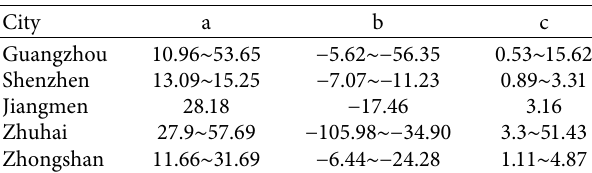
Figure 7: Variation curve of overconsolidation ratio with the depth in Zhongshan silt layer. (a) Project 1. (b) Project 2. Table 2: The values of coefficients in the polynomial equation in different